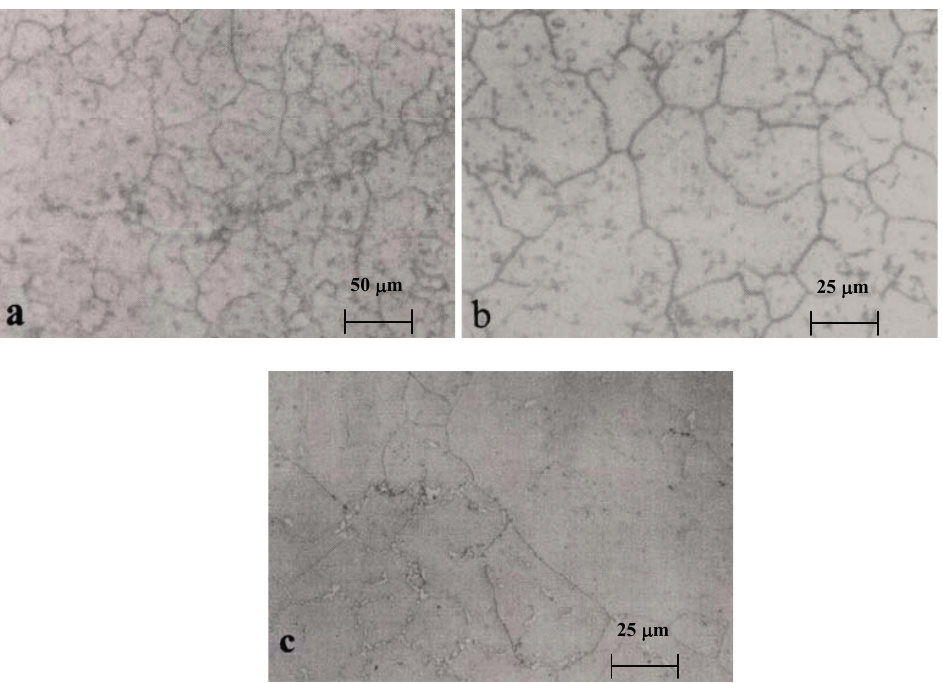
Figure 2. Representative optical microstructure at different stages of process, (a) & (b) as rolled sheet, (c) solution treated sheet.